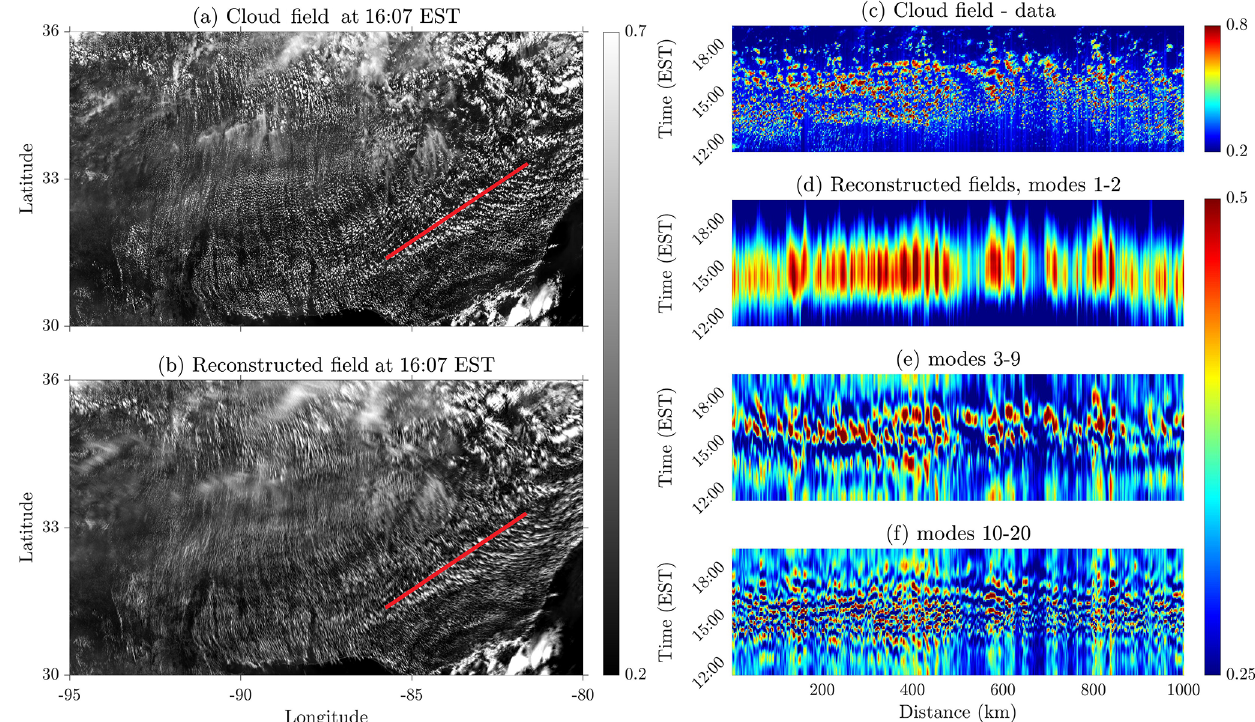
Figure 6. Snapshot of the cloud field (a) and the field reconstructed using all 20 modes (b) at 16:07EST. (c) Corrected reflectance as a function of time along the transaction marked in red in (a, b) . Same as in (c) but for the field reconstructed from modes 1–2 (d) , modes 3–9 (e) , and modes 10–20 (f)